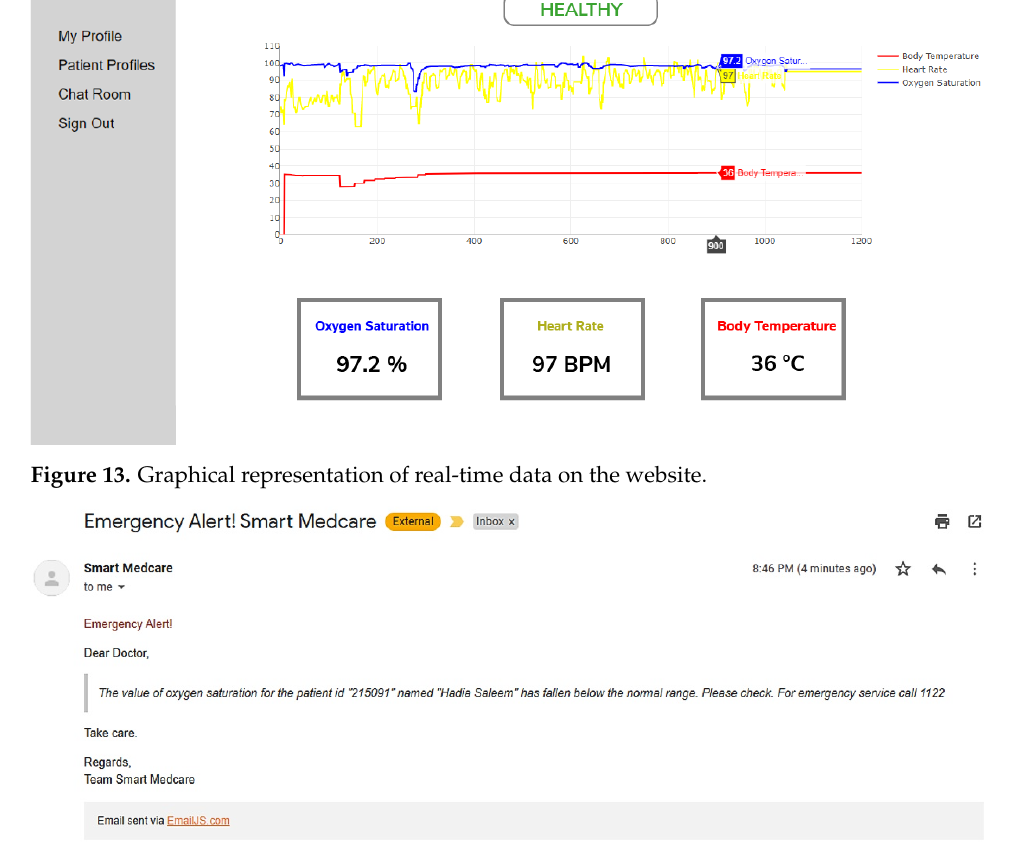
Figure 14. Emergency